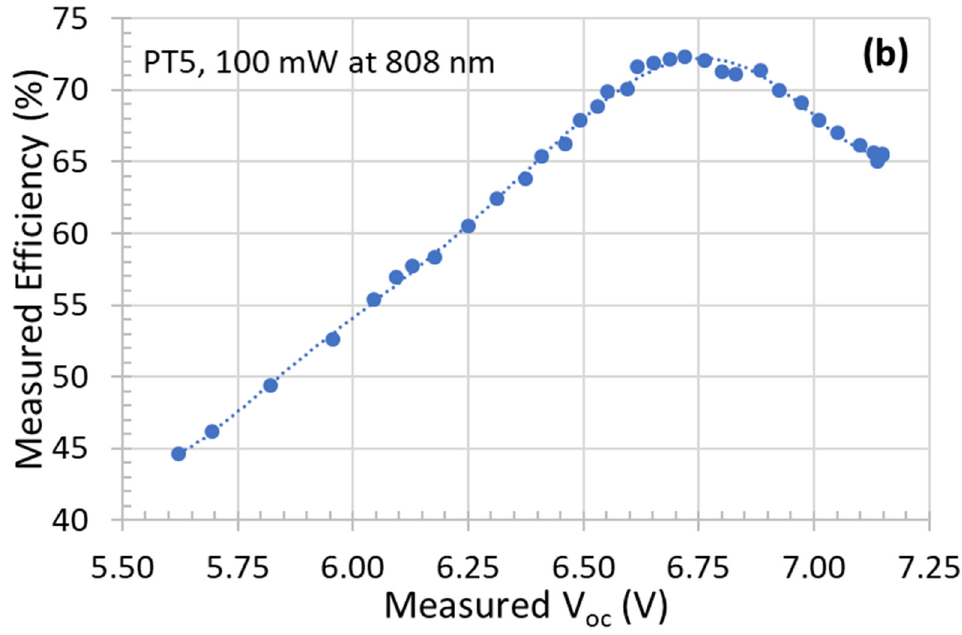
Figure 3. Measured V oc as a function of the temperature in ( a ), and measured conversion efficiency as a function of the measured V oc in ( b ) for a PT5 with an optical input at 808 nm.